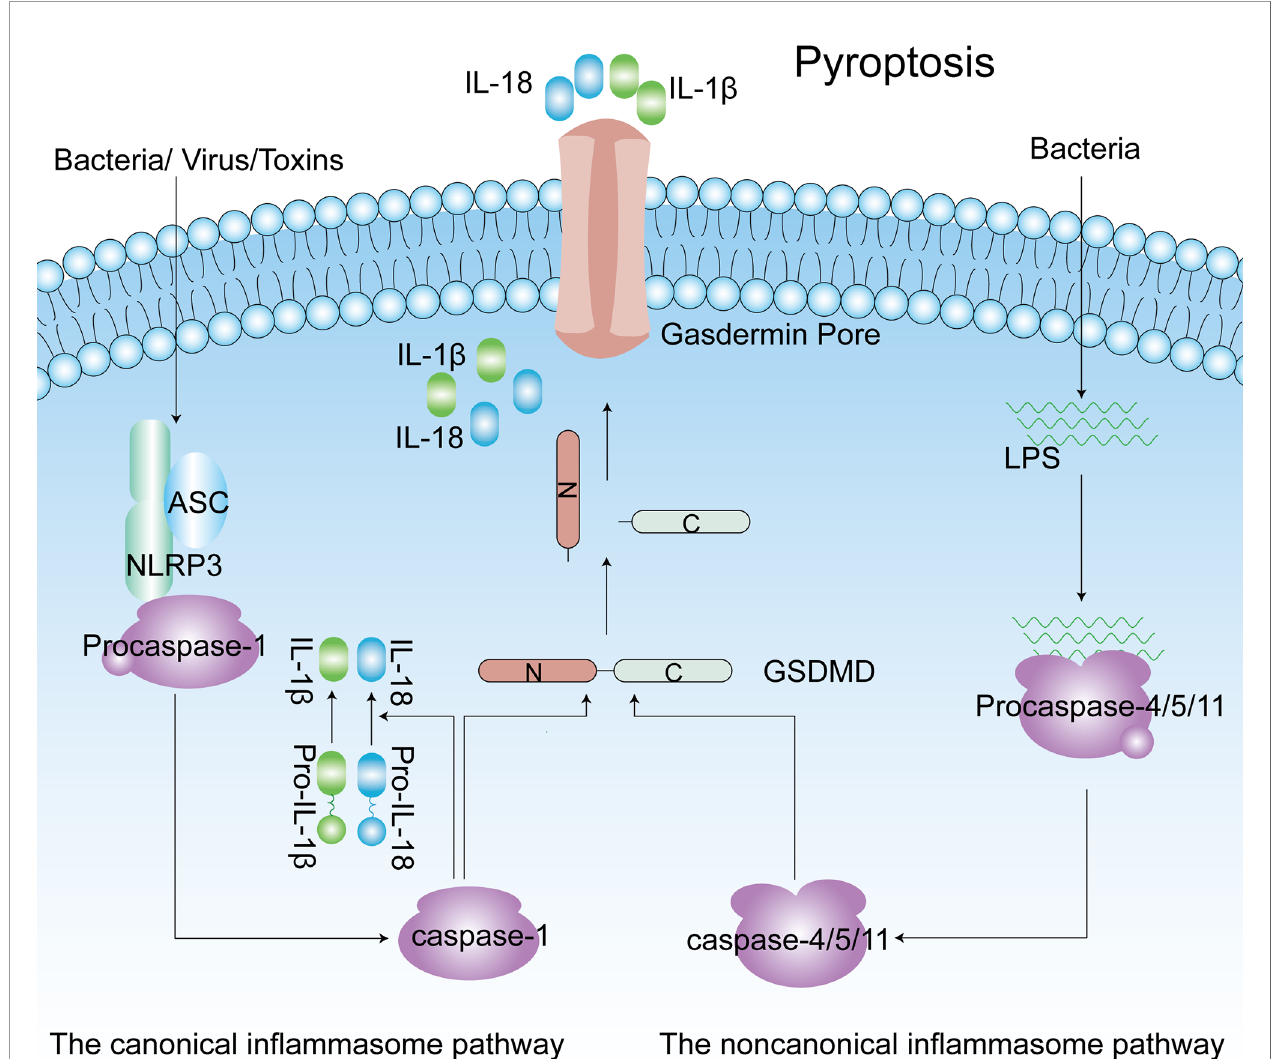
FIGURE 3 | The canonical in fl ammasome pathway (Caspase-1-dependent) and noncanonical in fl ammasome pathway (Caspase4/5/11-dependent) of pyroptosis. Caspase-1 is activated by NLRP3 in fl ammasomes, and caspase4/5/11 are activated by direct interaction with LPS. Active caspase-1 and caspase-4/5/11 cleave the GSDMD to produce the C-terminus and N-terminus. Released gasdermin-N domains form an approximately 12 – 14 nm inner diameter pore on the plasma membrane. IL-1 b and IL-18 are matured by active capase-1 and released from the gasdermin pore. ASC, apoptotic speck-like protein containing a caspase recruitment domain; IL-1 b , interleukin-1 b ; LPS, lipopolysaccharide; GSDMD, gasdermin D; NLRP3, NLR family pyrin domain-containing